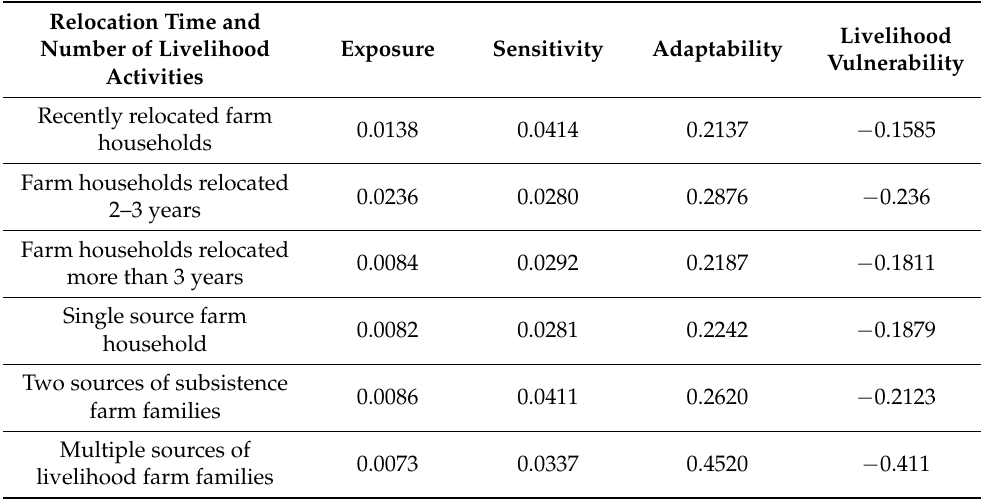
Table 5. Analysis of the exposure level, sensitivity, adaptive capacity, and livelihood vulnerability of households with different relocation time and different livelihood